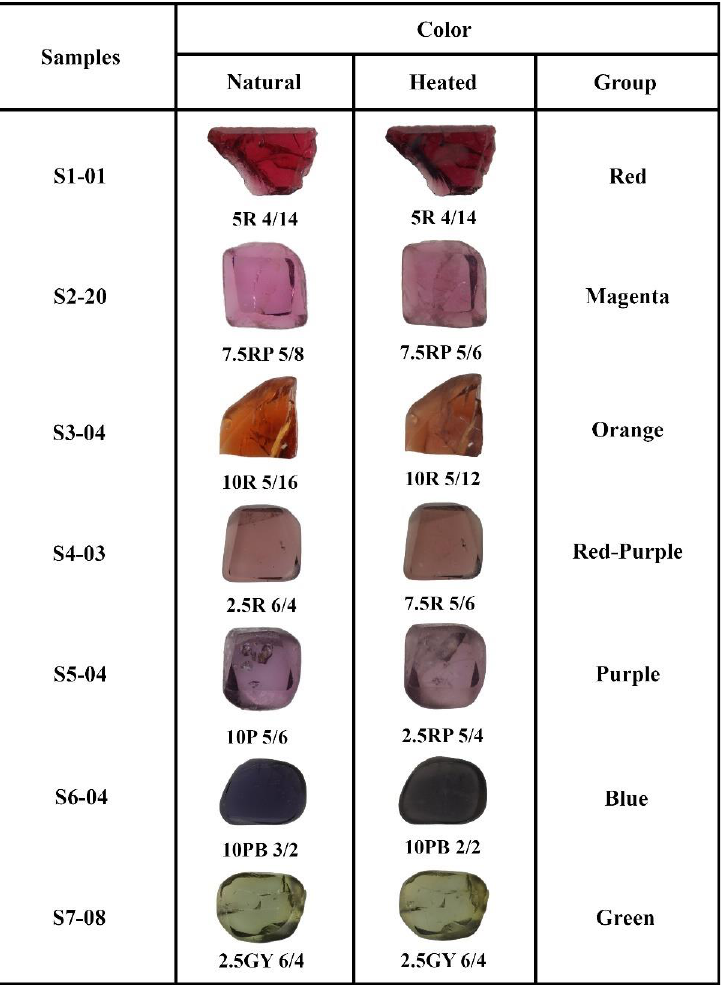
Figure 1. Representative spinel samples of each color group presenting appearances before and after heating as reported in the main text .